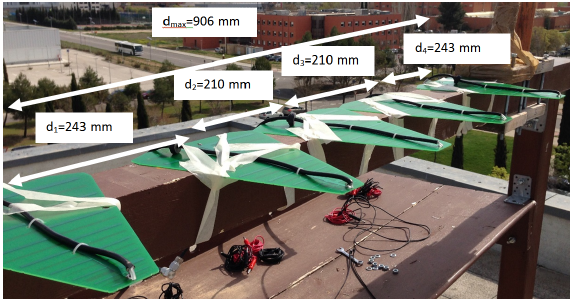
Figure 9. Designed NULA based on Televés 4G NOVA antennas without the radome detailing the inter-element spacing.